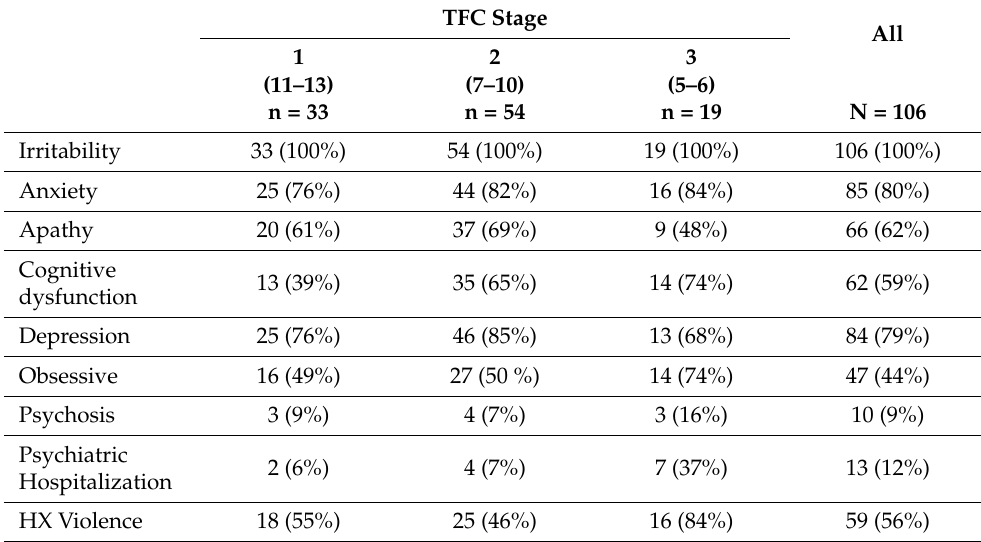
Table 3. Medical History of Psychiatric Symptoms by UHDRS TFC Stage.